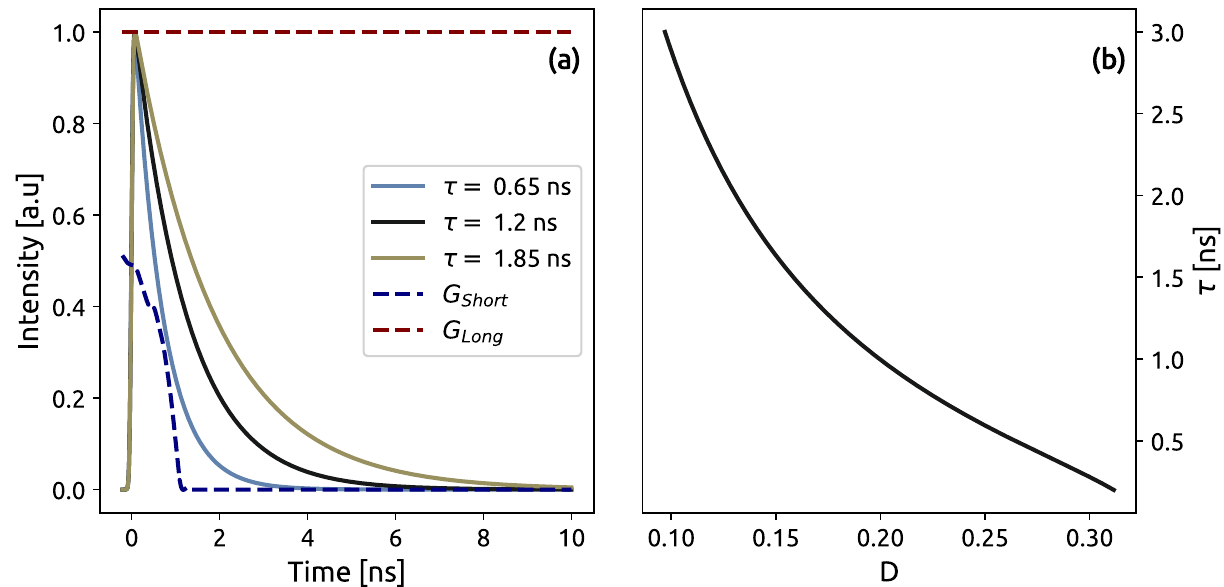
Figure 2. Simulated data, which forms the model for the DIME method. ( a ) Shows mono-exponential decay curves together with the gate functions for the long and short gates. Note that only the closing part of the short gate function is displayed, when the camera captures signal. ( b ) is the model of the simulated data using Eqs. (2) and (3), which is used to map an intensity ratio to a